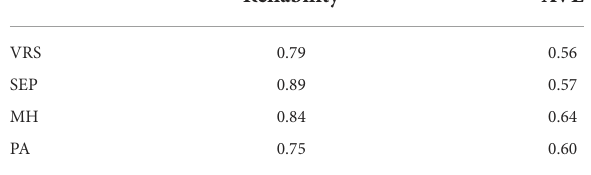
TABLE 8 Model fit